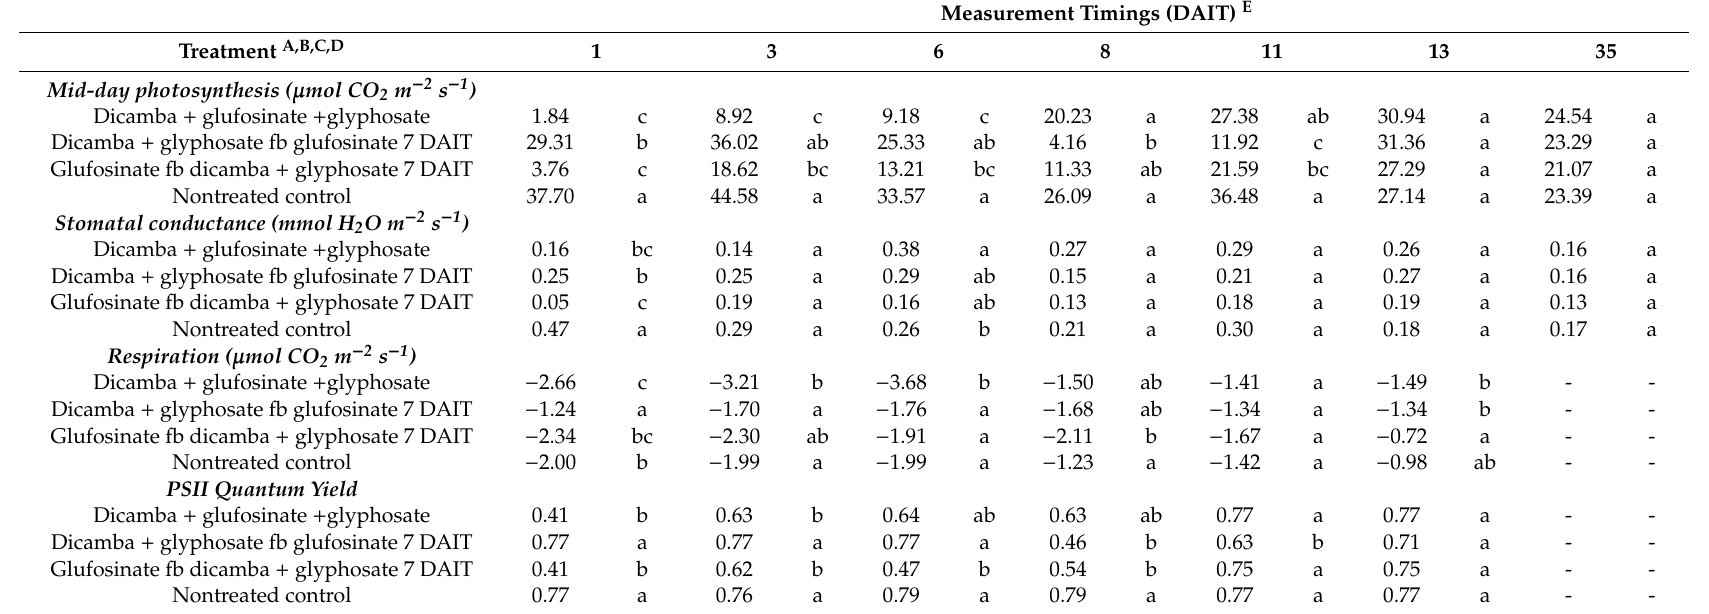
Table 6. Physiological measurements following herbicide applications in